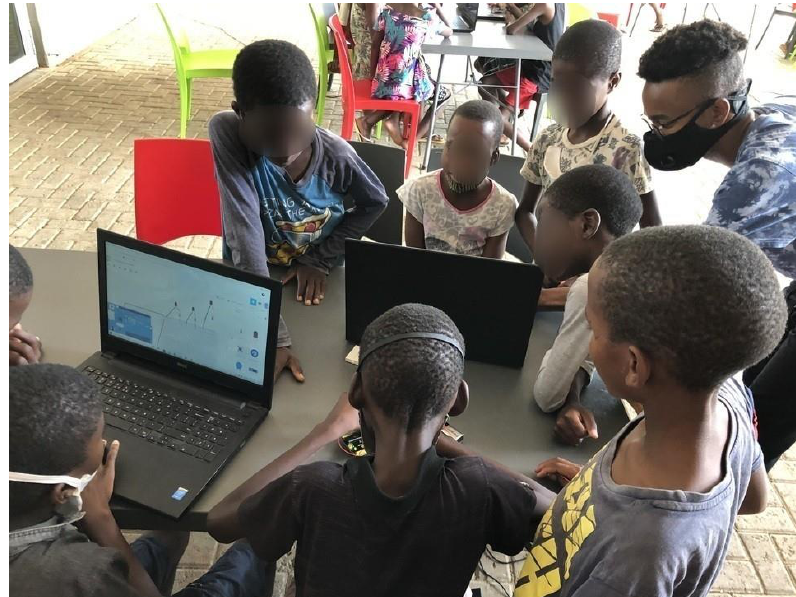
Figure 5. Learners working on Tinkercad.